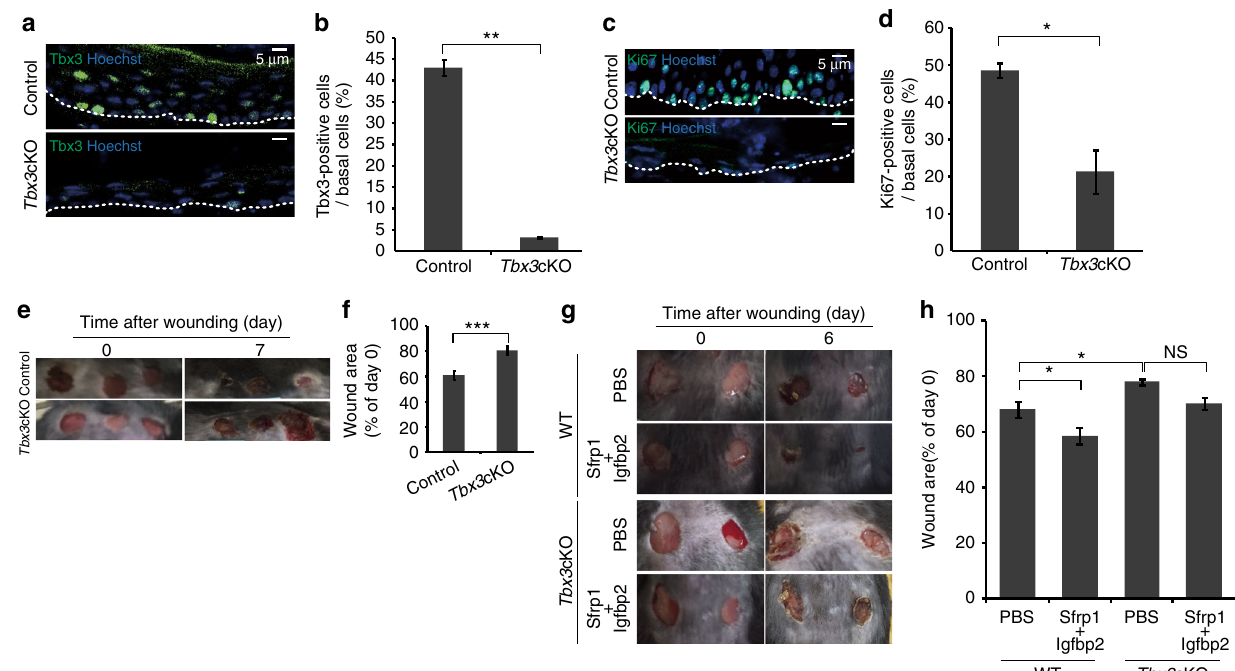
Fig. 6 Topical administration of Sfrp1 and Igfbp2 proteins facilitate tissue repair upon wounding. a , c Immuno fl uoresence of Tbx3 ( a ) or Ki67 ( c ) ( green ) and Hoechst ( blue ) on dorsal skin from control and Tbx3 cKO mice at 1-week post-wounding. b , d Quanti fi cation of Tbx3 + cells ( b ) and Ki67 + cells ( d ) in IFE basal layers from dorsal skin at 1-week post-wounding. e Representative images of dorsal skin of control and Tbx3 cKO mice at days 0 and 7 post- wounding. f Quanti fi cation of wound healing. The diameter of each wound site was measured, and the average diameter at day 7 post-wounding relative to that at day 0 is shown. g Representative images of dorsal skin of wild-type and Tbx3 cKO mice at day 6 post-wounding injected with or without Sfrp1 and Igfbp2 proteins. The proteins were injected once per day for 4 days after induction of wounding. h Quanti fi cation of wound healing. The average diameter of each wound site at day 6 post-wounding relative to that at day 0 is shown. b , d Data represent the mean ± s.e.m. of averages of three independent experiments ( n = 3). More than 500 cells were analysed to calculate the average in each experiment; * P < 0.05, ** P < 0.01, analysed by the two-tailed t - test. f , h Data represent the mean ± s.e.m. of averages of twelve wound sites ( n = 12) pooled from three mice; * P < 0.001, *** P < 0.001 analysed by the two-tailed t -test ( f ) or Tukey ’ s multiple comparison test ( h ). a , c , e , g White-dotted lines represent basement membranes. Experiments were repeated